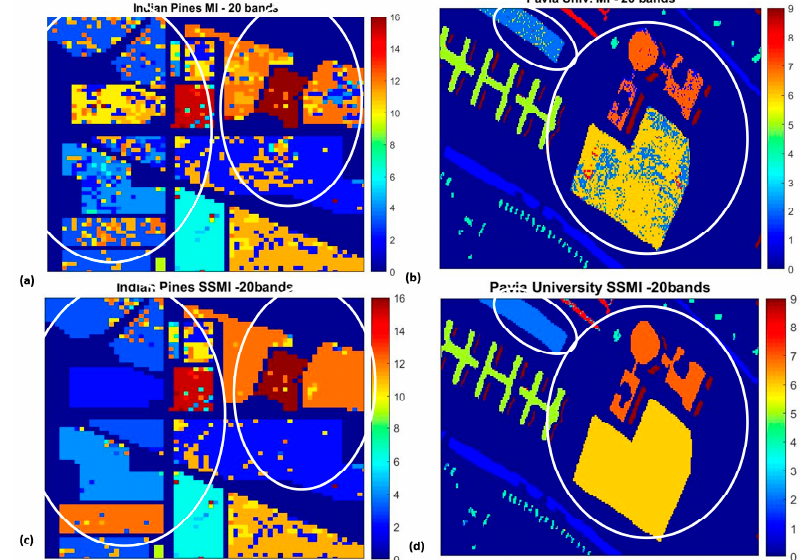
Figure 10. The zoom-ins of the false color classification maps in Figure 9 to highlight the substantial reduction of classification false alarms in the classes (circled) when the bands are selected through the SSMI BS method. Left column ( a,c ): Portion of Indian Pine, Right column ( b,d ): Pavia University dataset. The classification results using bands selected by the MI BS (Upper panel) and those proposed by the SSMI BS scheme (Lower panel).